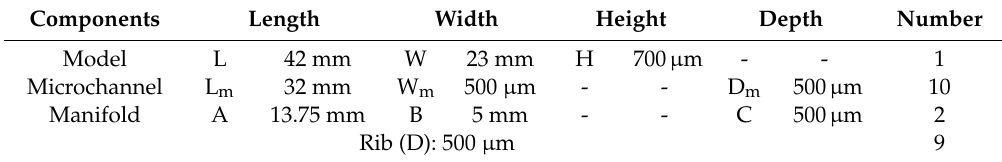
Table 1. The geometric parameters.